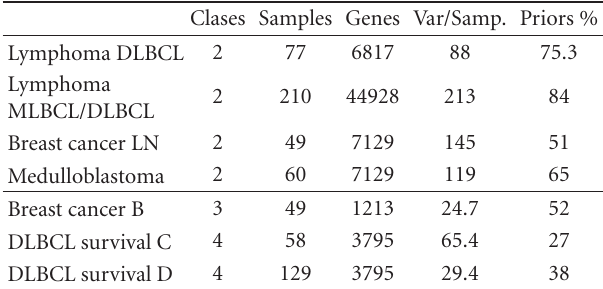
Table 1: Features of the di ff erent cancer datasets Clases Samples Genes Var/Samp. Priors